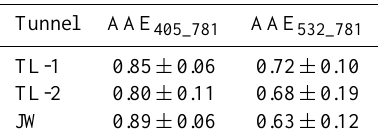
Table 3. The derived AAE BC values and uncertainties in the tunnel